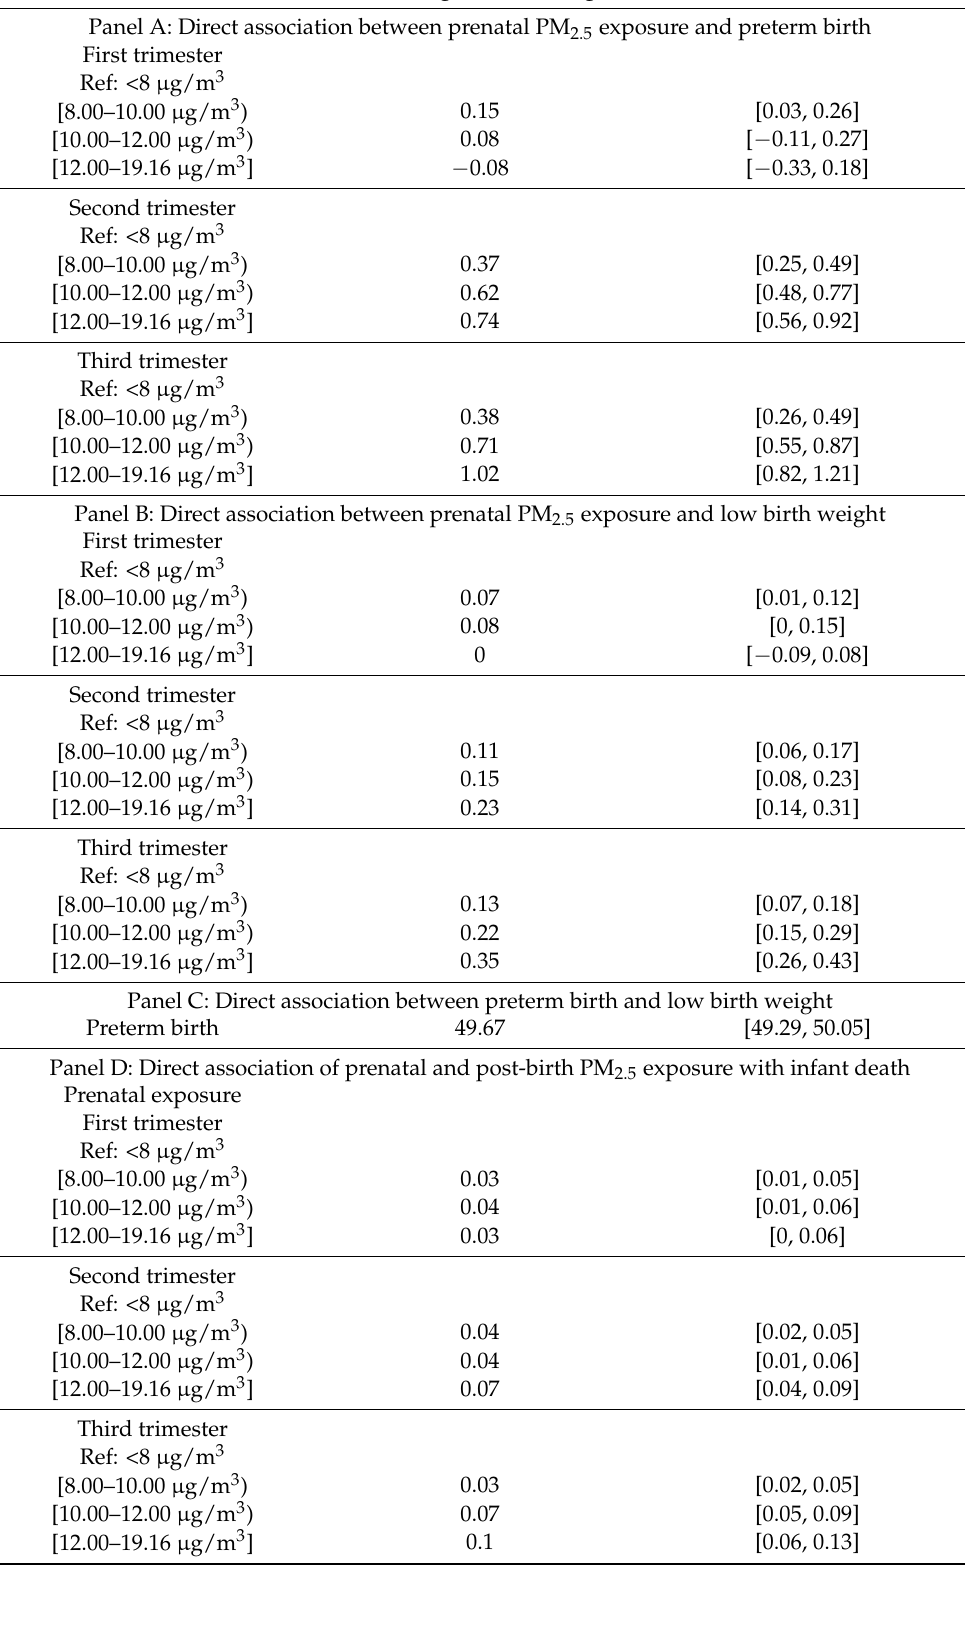
Table 2. Estimates of the association between prenatal PM 2.5 exposure, post-birth PM 2.5 exposure, preterm birth, low birth weight, and infant mortality from the Structural Equation Model. Percentage Point Change 95% Confidence Interval Panel A: Direct association between prenatal PM 2.5 exposure and preterm birth